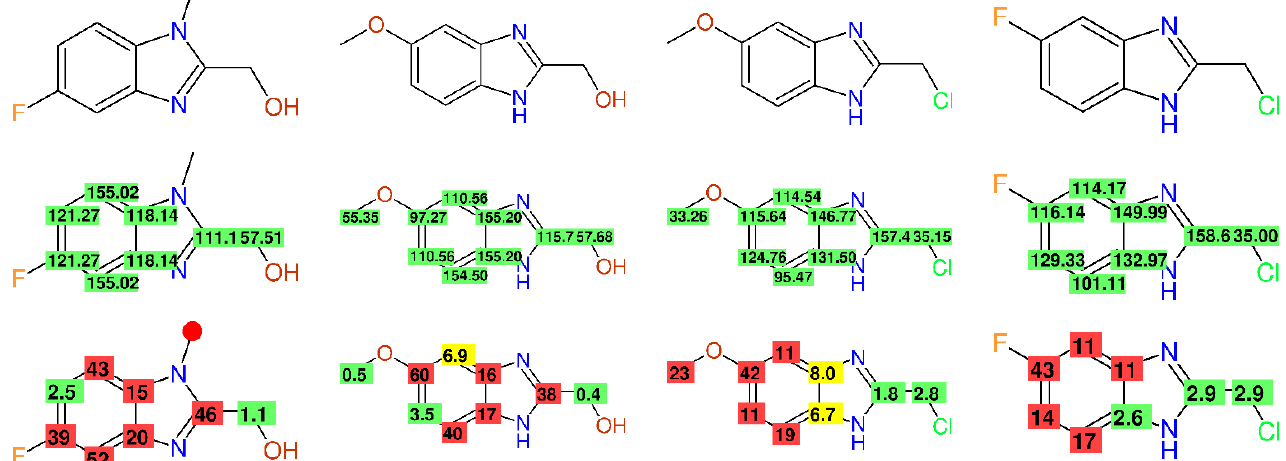
Figure 4. 13 C-NMR data of compounds 51 , 26 , 34 , and 37 (columns from left to right ) as published in [37], together with the published chemical shift values and the differences between the experimental and predicted chemical shift values.